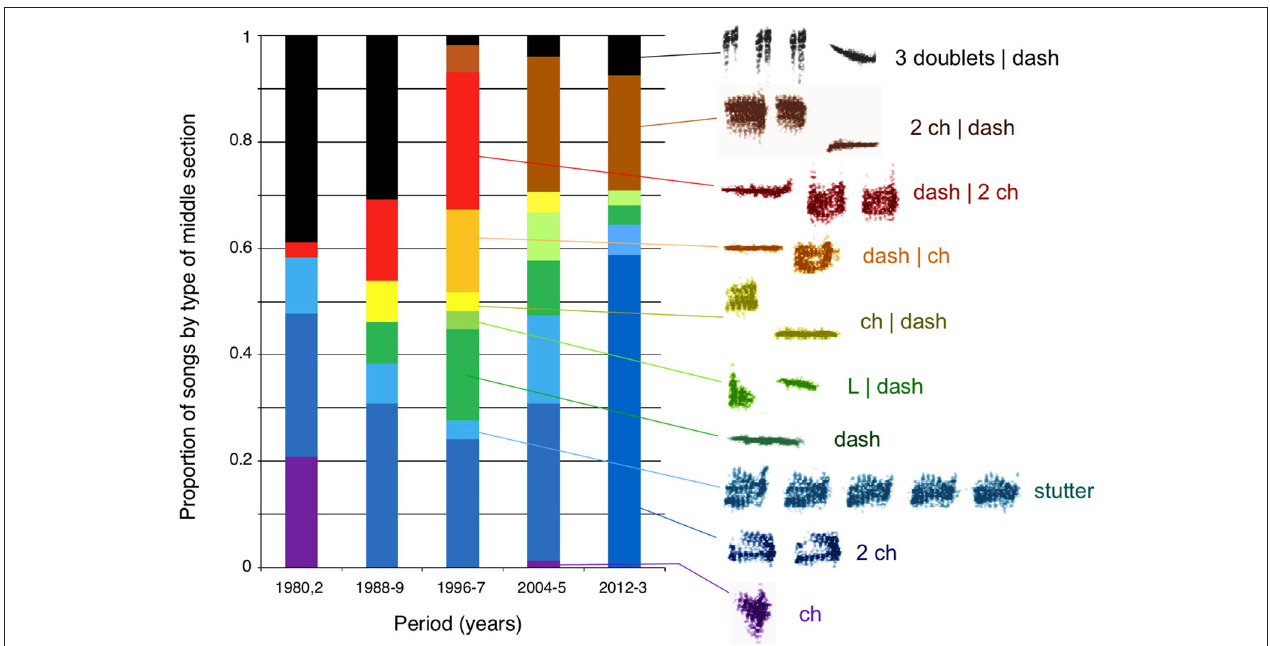
FIGURE 3 | Changes in the prevalence of types of middle sections of Savannah sparrow song. Middle section types were defined based on the type, number, and order of syllables. The two main classes of notes in middle sections are “ch” notes (noisy, with multiple frequencies), and “dash” notes (tonal). Three types of middle section were composed solely of ch notes, differing in the number of notes, either 1 (violet), 2, (dark blue), or > 2 (a “stutter,” light blue). Dash notes (dark green) made up the middle section or were combined with one or more ch notes, with the dash note falling in either the first or last position (brown, red, orange, and yellow). An “L” note (modified low-frequency ch note) followed by a dash (light green) formed another category. Noisy doublets followed by a dash (black) made up the final category plotted here. For the purposes of clarity of illustration, some categories that are split elsewhere are combined here (After Williams et al.,